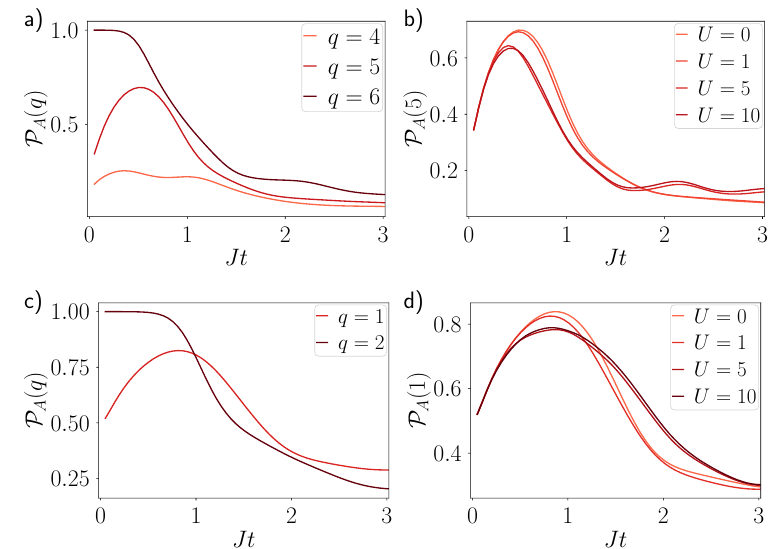
Figure 5: Symmetry-resolved purity for the Bose-Hubbard model in one